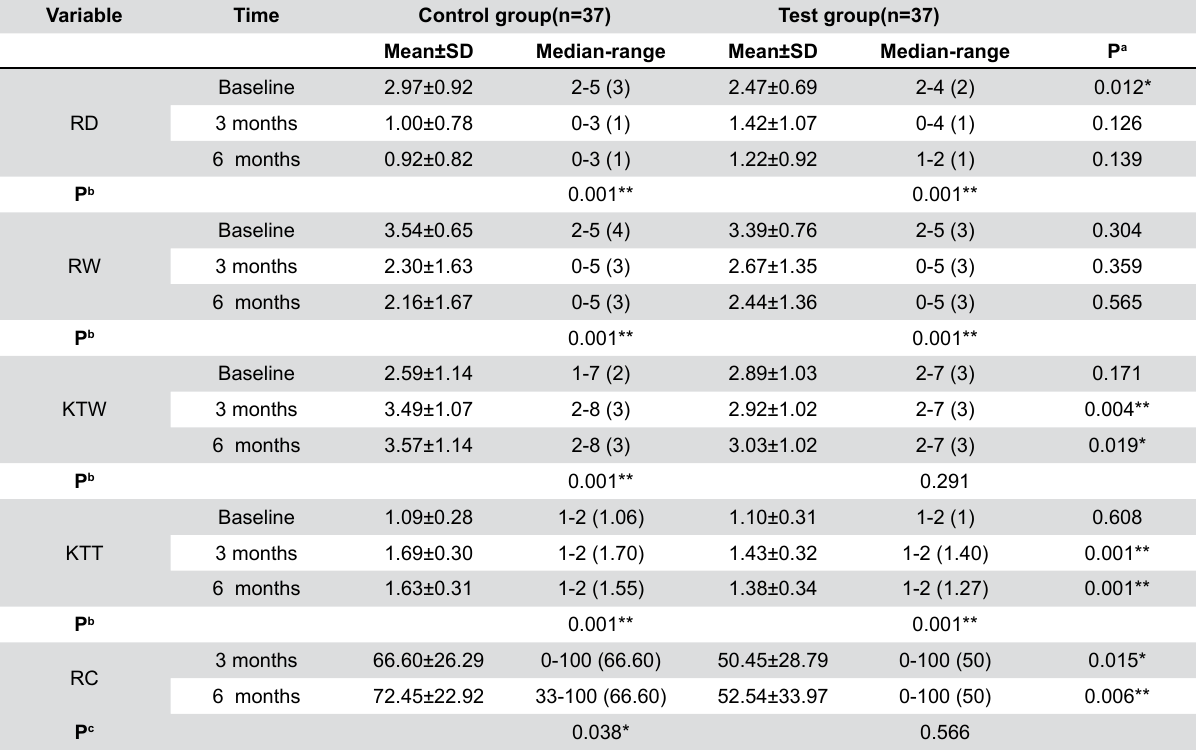
Table 2- Evaluation of RD, RW, KTW, KTT and RC clinical parameters and